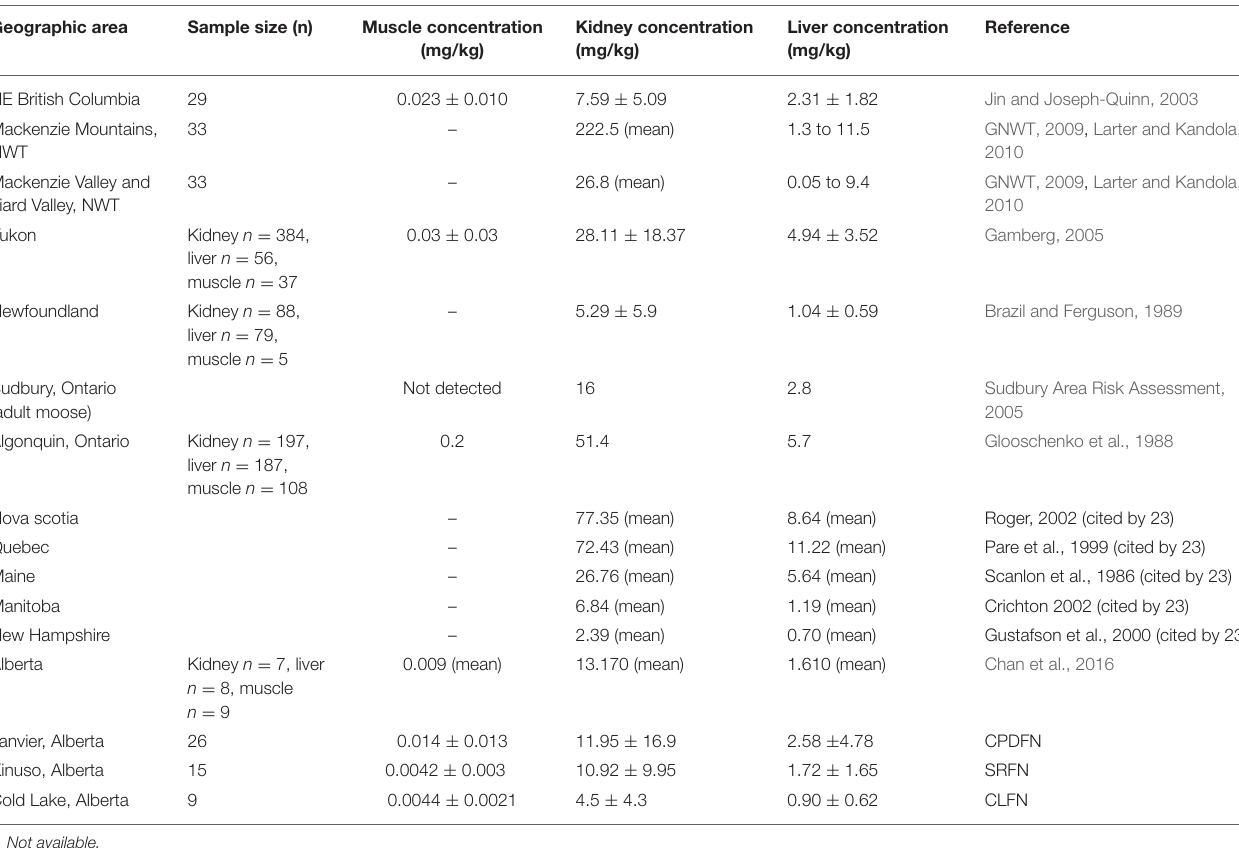
TABLE 8 | Summary of cadmium tissue concentrations. Geographic area